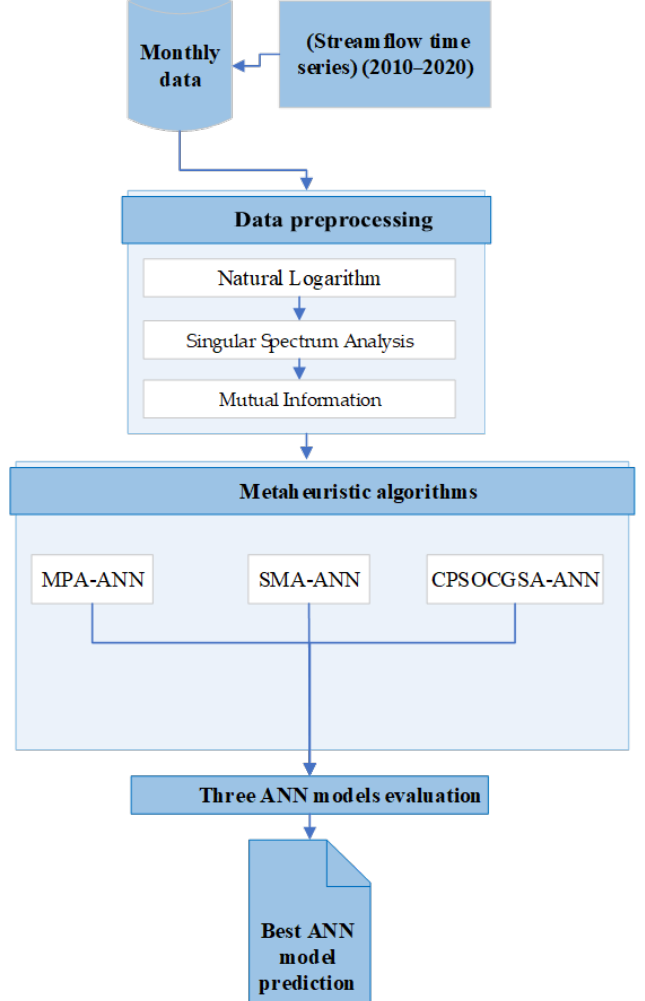
Figure 3. A scheme of the proposed methodology to simulate the monthly streamflow data.